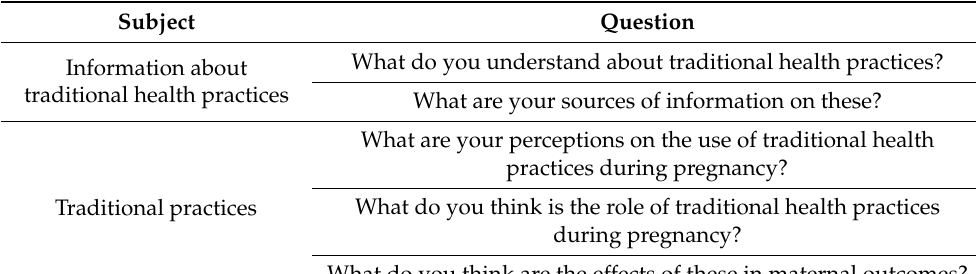
Table 1. Sample of major questions asked during